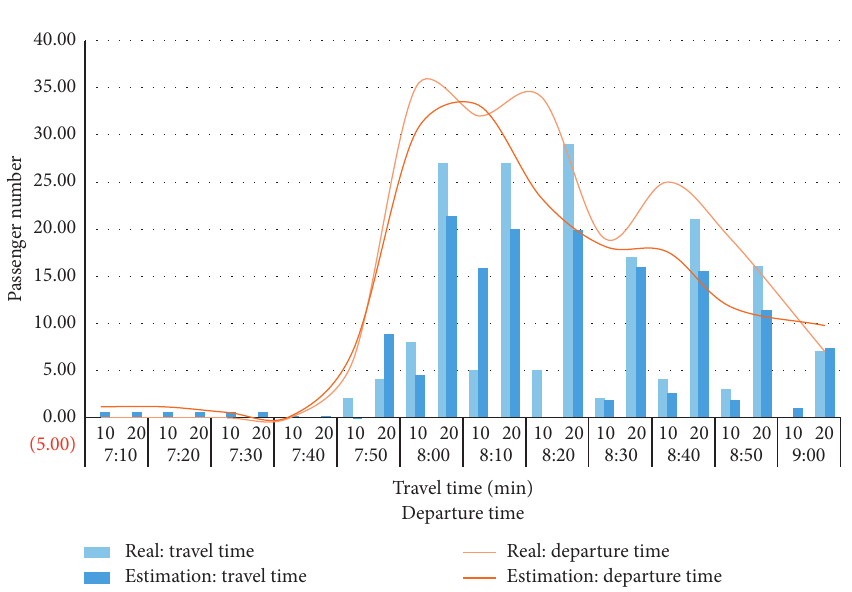
Figure 10: Estimation results from Chongwenmen to